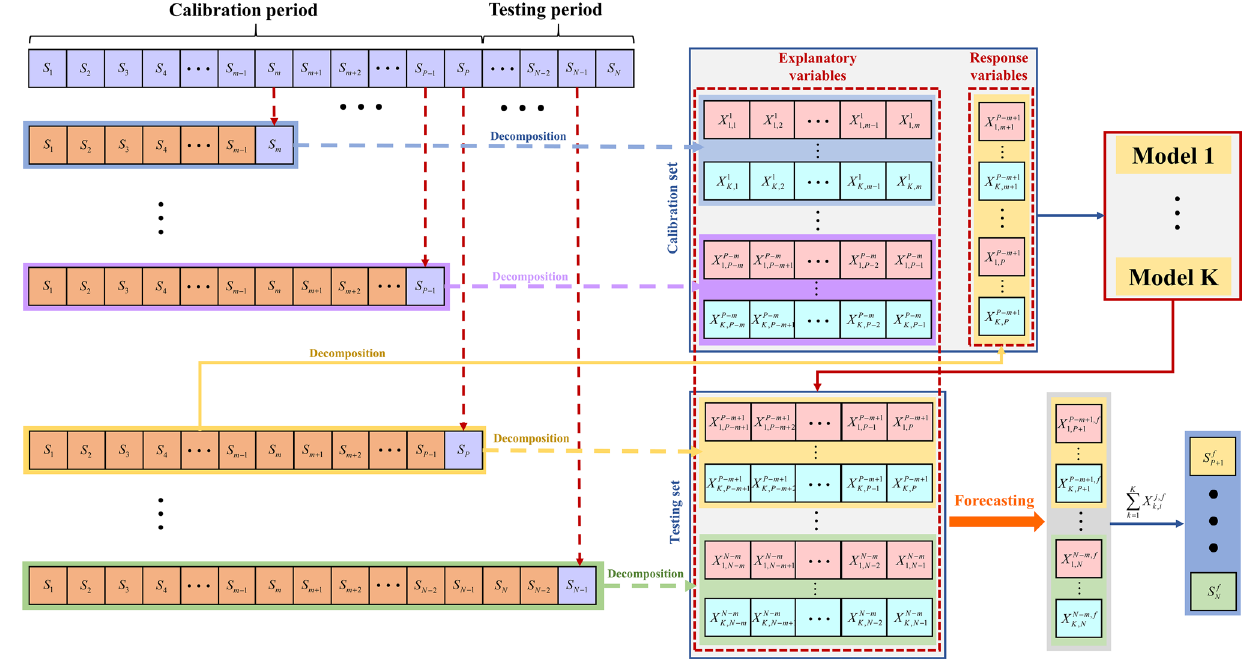
Fig. 3 The process of FSD sampling